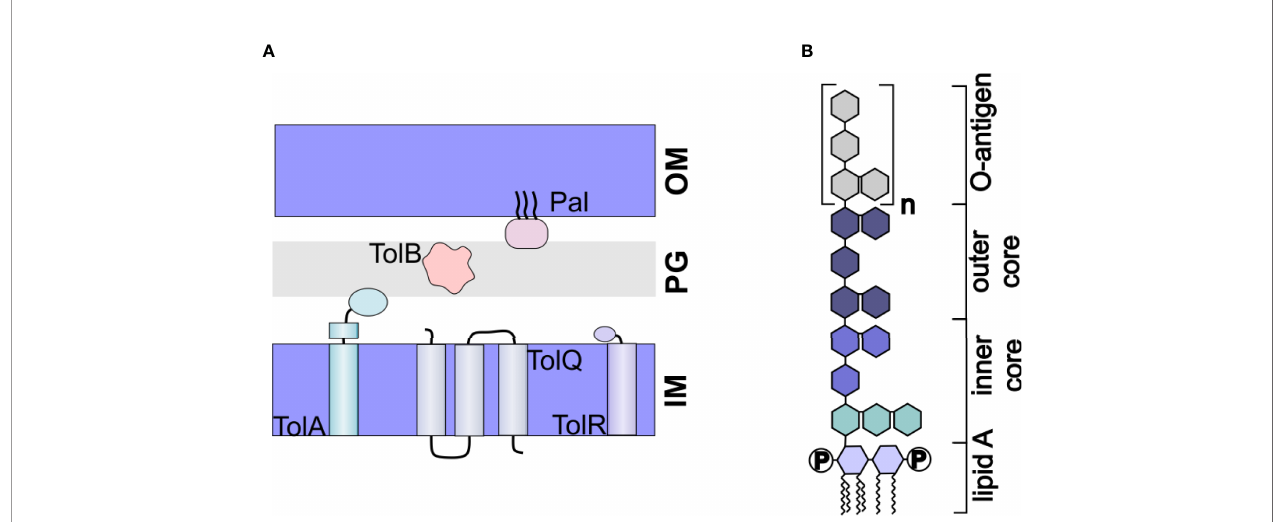
increased vesiculation in E. coli (72, 73). A similar approach that included mutation of the tolR gene along with the galU gene, which is involved in LPS biogenesis, was found to increase vesiculation in Shigella sonnei (74). In Helicobacter pylori , deletion of tolB but not pal increased vesiculation (75).